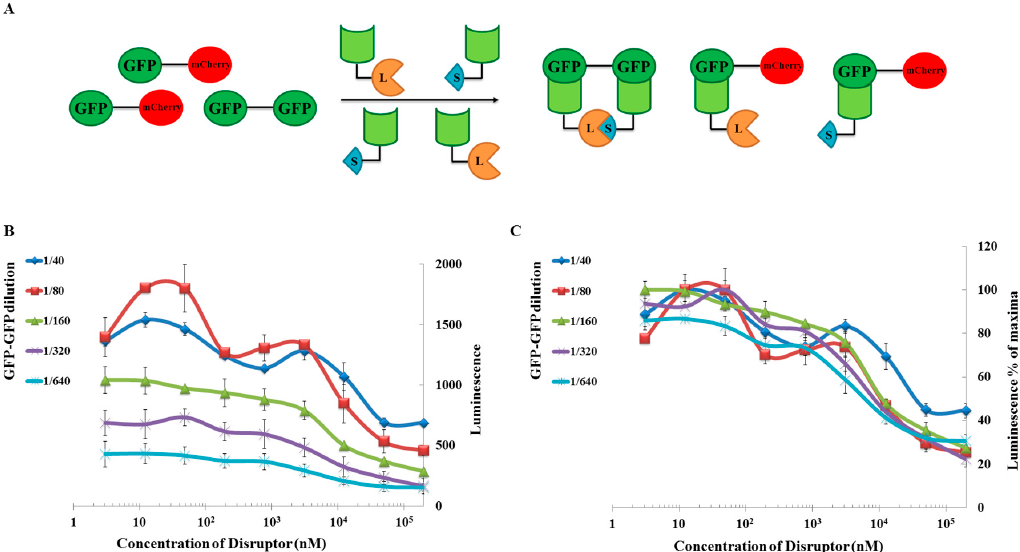
Figure 5. Detection limit studies using a competition approach. ( A ): Schematic representation of the indirect approach that was used to study the detection limit of the split-luc assay. For the assay, along with the SLN bits and the target protein, we expressed the competitor in a Leishmania cell-free system, and this was used for our assays. The competitor was incubated with SLN bits allowing it bind to the nanobody before adding the target protein and the substrate; ( B ): Graphical representation of luminescence as a function of competitor concentration; ( C ): Normalized data-set from the data obtained for graph 5B. The data was normalized against the maximum luminescence obtained for each target concentration and plotted against the competitor concentration. The data-set for each target concentration seems to overlap, suggesting that the inhibition curves obtained were independent of target protein concentration.